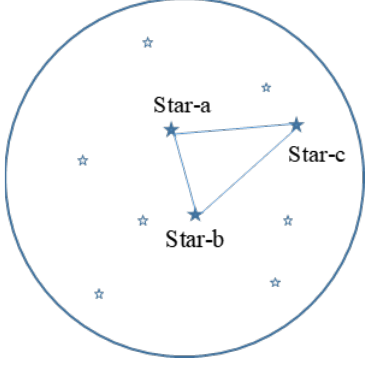
Figure 1. Triangle unit built.